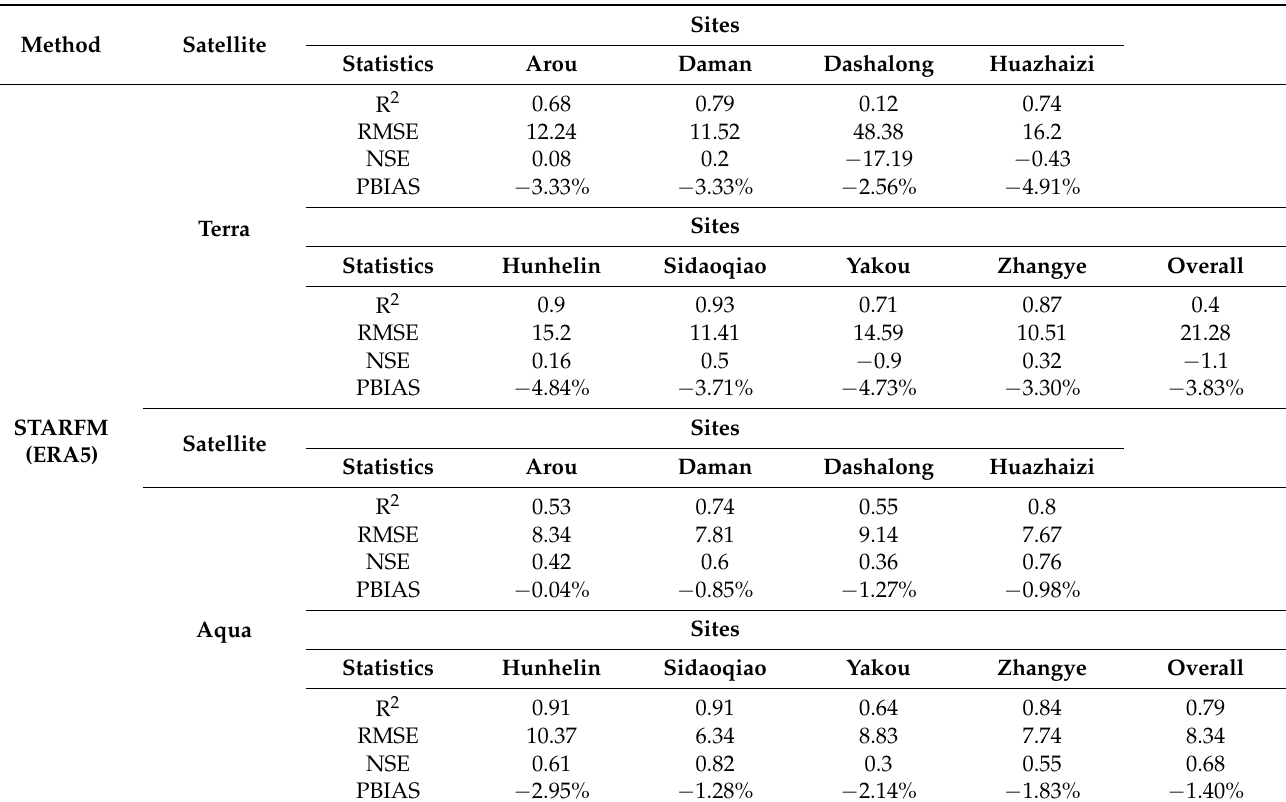
Table 4. The general performance results of reconstructed LST based on ERA5 data using STARFM from 2016 to